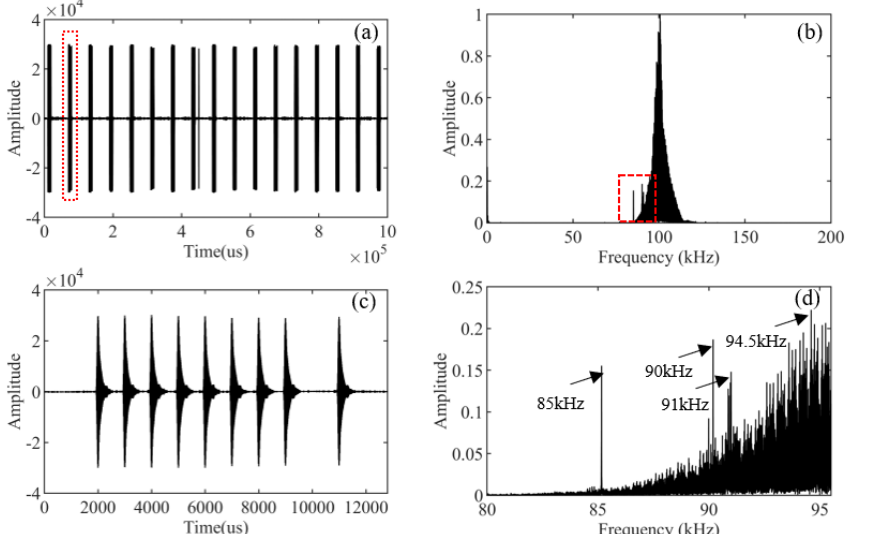
Figure 11. The actual data and spectrum. ( a ) The actual Loran-C signal. ( b ) The actual Loran-C signal spectrum. ( c ) A Loran-C pulse set. ( d ) Details of the spectrum